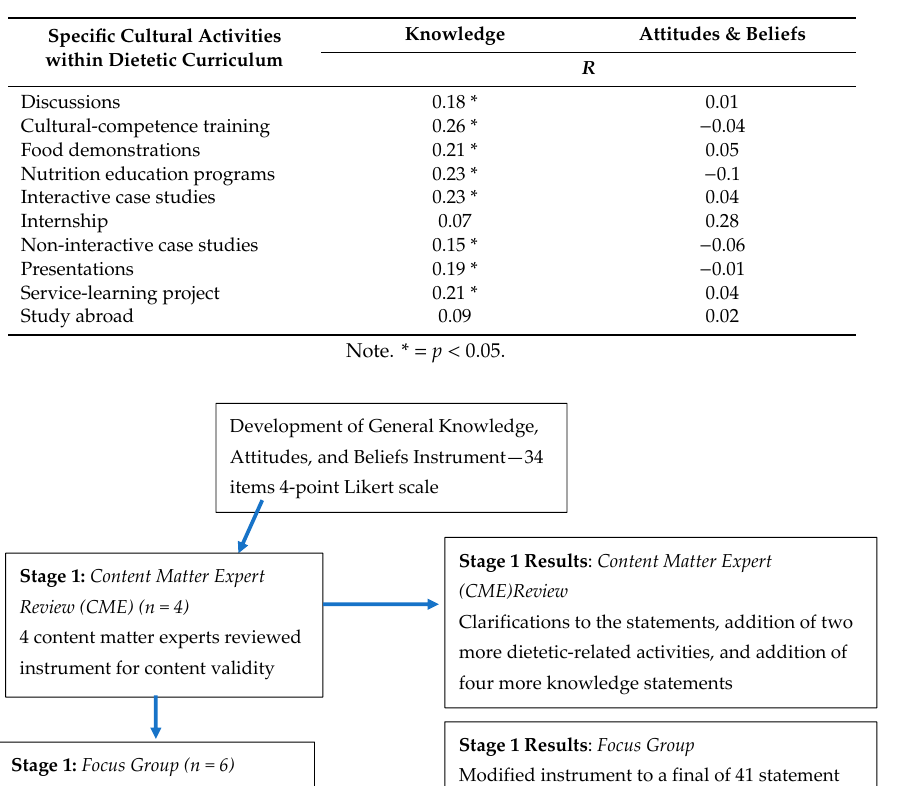
Table 7. Spearman correlations among general KAB scores and specific activities ( n = 187).